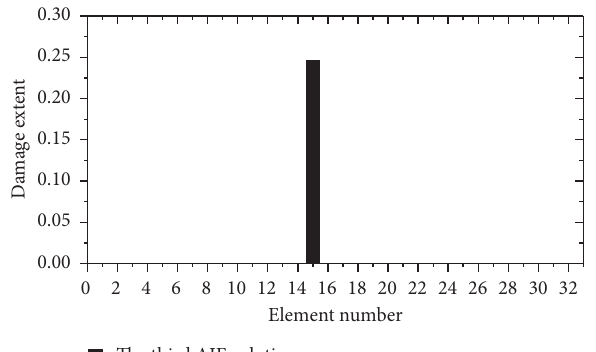
Figure 5: Damage assessment result by the third AIE when element 15 is damaged.